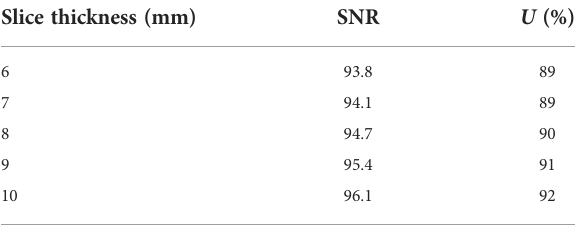
TABLE 5 SNR and uniformity as a function of the slice thickness.